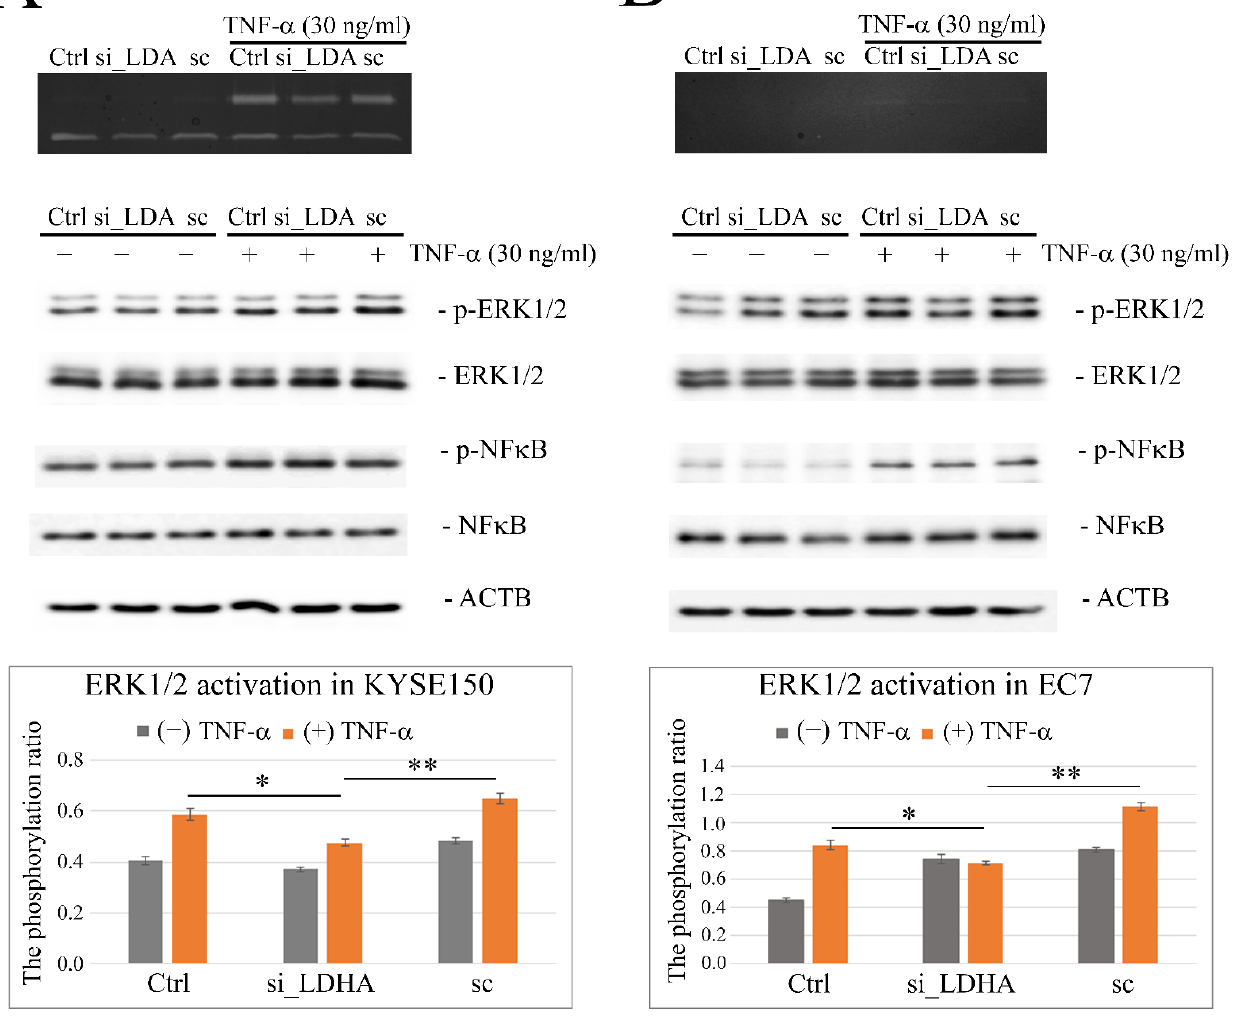
Figure 8. The effect of LDHA gene silencing on activation of TNF- α -induced MMP9-related ERK1/2 and NF κ B signaling pathways in esophageal cancer cells. LDHA siRNA-associated downregulation of MMP9 in response to TNF- α in KYSE150 cells, seen in gelatin zymography (upper) and levels of total and phosphorylated ERK1/2 and NF κ B/p65 proteins in ( A ) KYSE150 cells ( B ) and EC7 cells transfected with LDHA siRNA, subjected or not to hourly TNF- α stimulation (30 ng/mL), visualized by Western blotting. Quantitative analysis using the differential densitometry of TNF- α -induced ERK1/2 activation in the form of bar graphs, showing the ratio of phospho-ERK1/2 (Thr202/Tyr204) normalized to total ERK1/2 in LDHA siRNA-transfected and control cells (bottom panels). Ctrl — control; si_LDHA — LDHA siRNA; sc — scrambled sequence siRNA; * p < 0.05; ** p < 0.005.